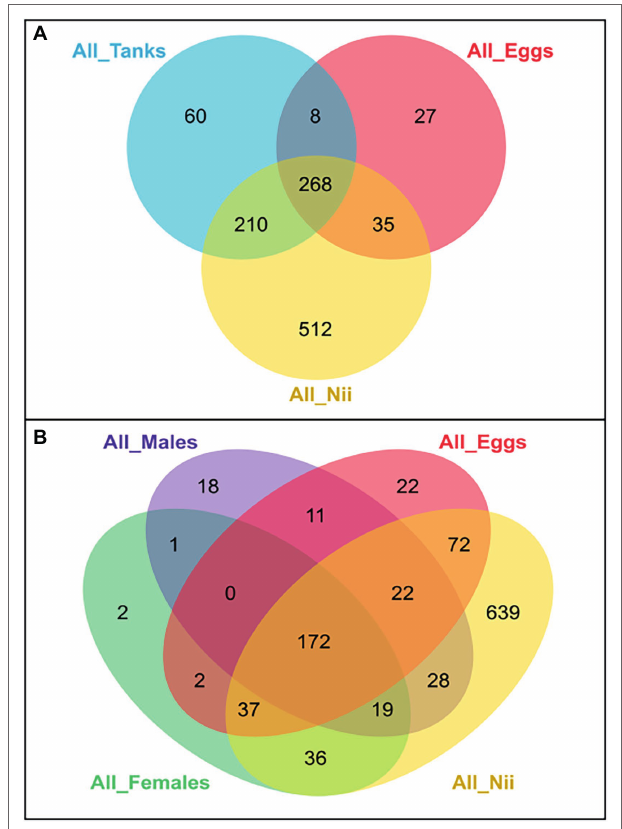
FIGURE 3 | Global Venn diagrams of shared and specific ASVs among sample types. (A) Venn diagram of specific and shared ASVs among the tank water, the egg and the nauplius (nii) samples. The blue ellipse represents the ASVs shared by all the hatchery tank water samples. The red ellipse represents the ASVs shared by all the egg samples. The yellow ellipse represents the ASVs shared by all the nauplius (nii) samples. (B) Venn diagram of specific and shared ASVs among the breeders (female and male), the egg and the nauplius (nii) samples. The green ellipse represents the ASVs shared by all the female reproductive organ samples. The purple ellipse represents the ASVs shared by all the male reproductive organ samples. The red ellipse represents the ASVs shared by all the egg samples. The yellow ellipse represents the ASVs shared by all the nauplius (nii) samples. In both Venn diagrams, numbers noted in the overlapping areas correspond to the number of shared ASVs among sample types, while numbers noted outside of the overlapping areas correspond to the numbers of specific ASVs associated with each sample